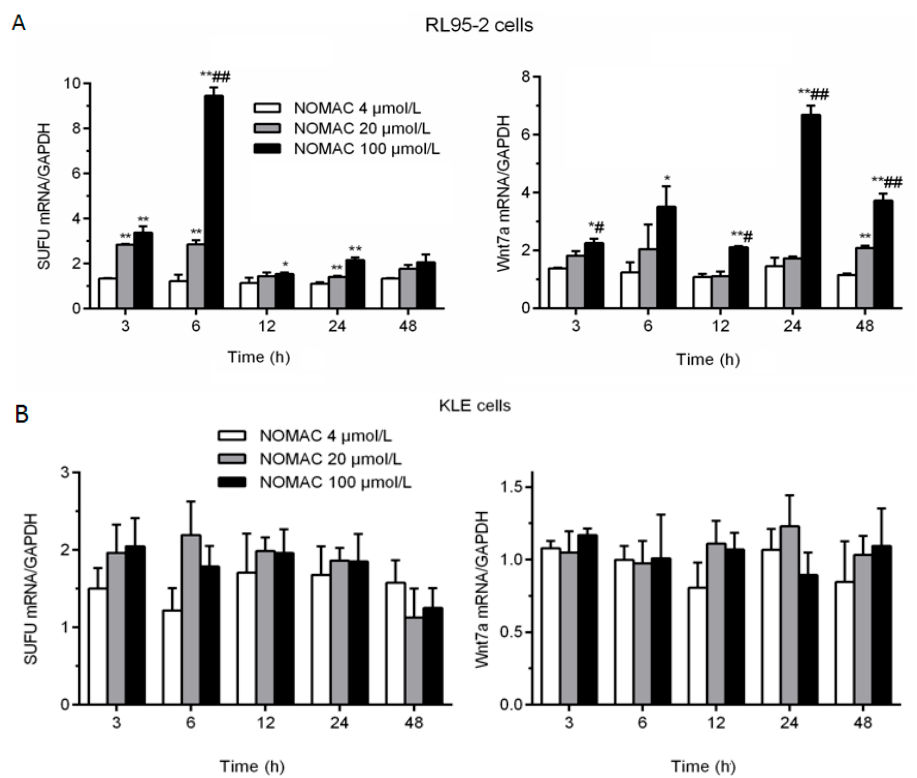
Figure 3. Effects of NOMAC on the mRNA levels of SUFU and Wnt7a in cultured cells (RL95-2 and KLE), as assessed by RT-qPCR. RL95-2 and KLE cells were exposed to NOMAC (0, 4, 20, and 100 μ mol/L) for various time points. Data are presented as fold changes relative to the mRNA expression levels of GAPDH. All of the results were from three independent experiments and expressed as mean ± SD. ( A ) The relative abundance of SUFU and Wnt7a mRNA in RL95-2 cells; ( B ) The change in the mRNA expression levels of SUFU and Wnt7a in KLE cells. * p < 0.05, ** p < 0.01 relative to the 4 μ mol/L NOMAC group; # p < 0.05, ## p < 0.01 relative to the 20 μ mol/L NOMAC group.